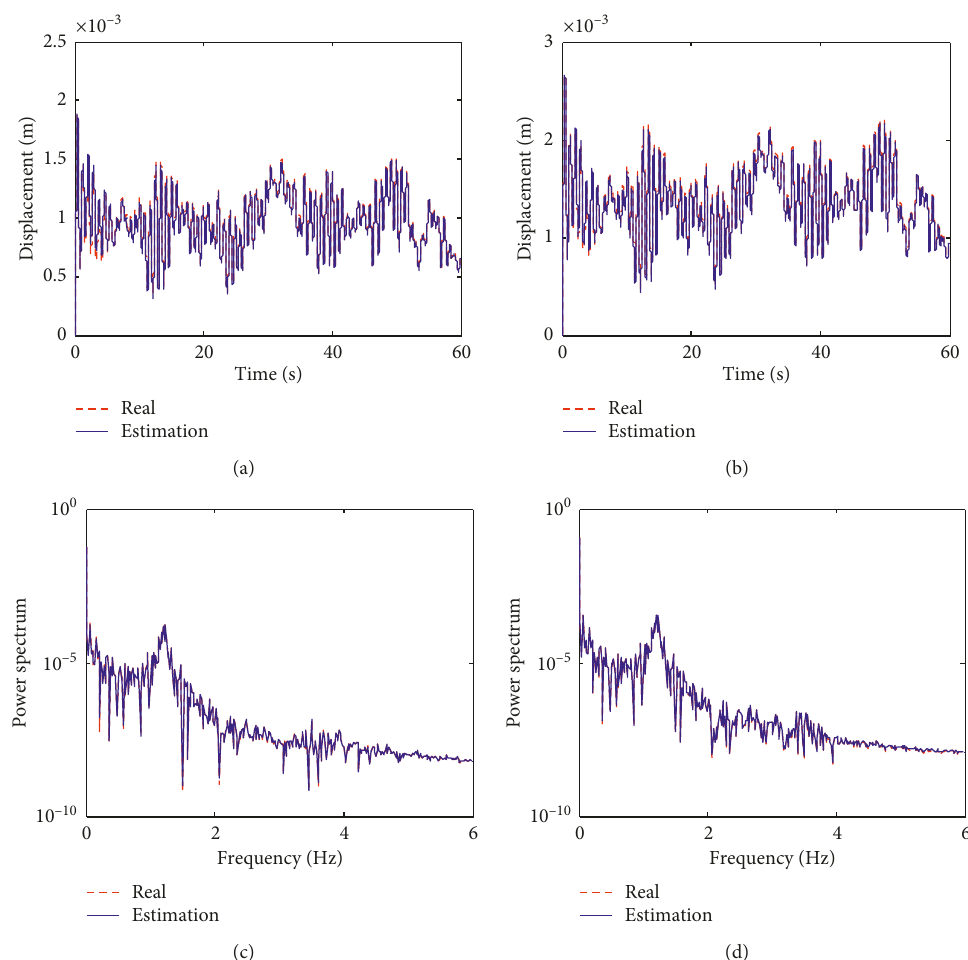
Figure 3: Comparison of the structural displacement responses for time and frequency domains. Displacement vs time on the (a) fifth floor and (b) tenth floor. Frequency vs power spectrum on the (c) fifth floor and (d) tenth